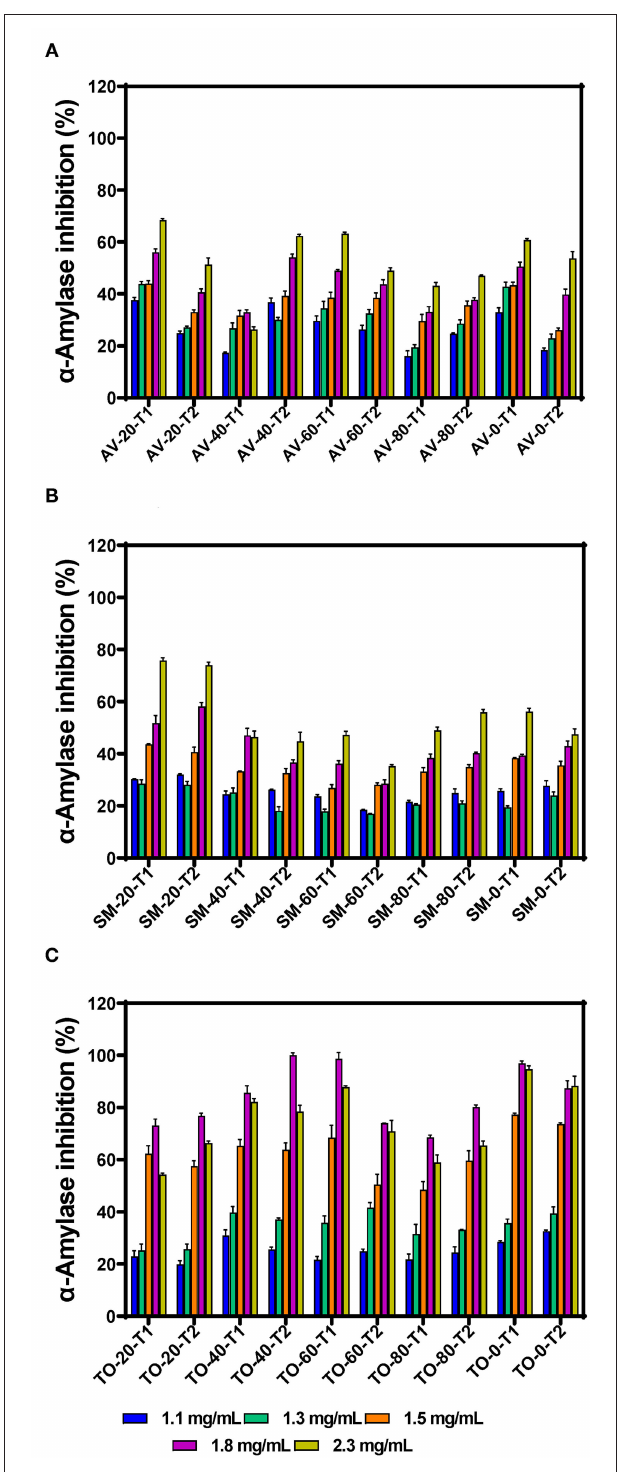
FIGURE 1 | α -amylase inhibition by aqueous extracts from the dried leaves of (A) Amaranthus viridis (AV), (B) Solanum macrocarpon (SM) and (C) Telfairia occidentalis (TO). Plants were produced with different urea fertilizer doses (0, 20, 40, 60, and 80 kg N/ha), which were applied at (T1) or after (T2) planting. Each bar is the mean of 3 determinations while the error bar represents standard